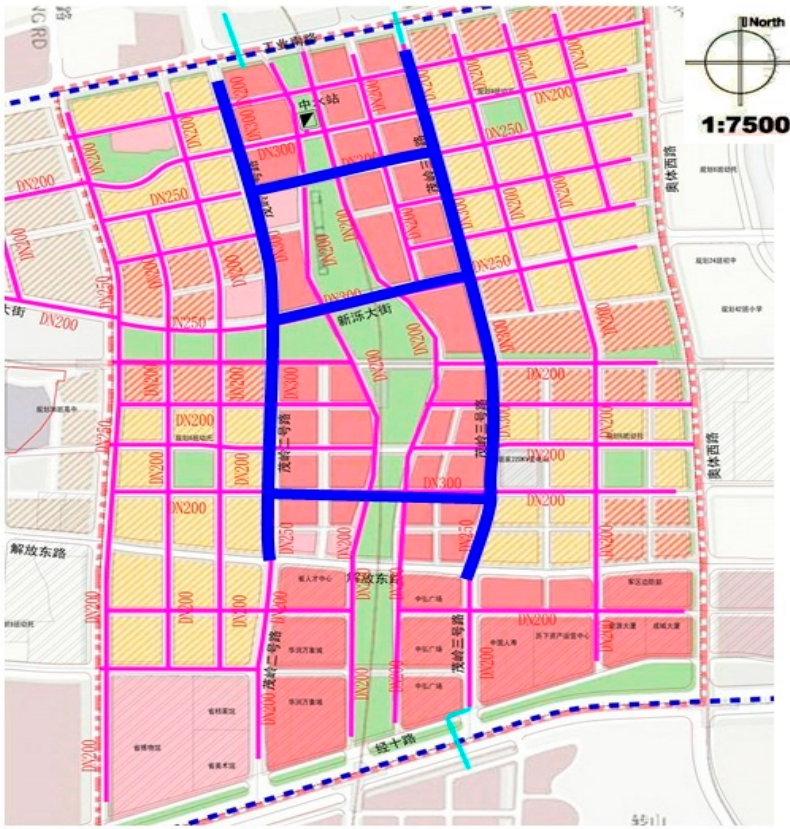
Figure 9. The planned layout of the proposed water distribution system.